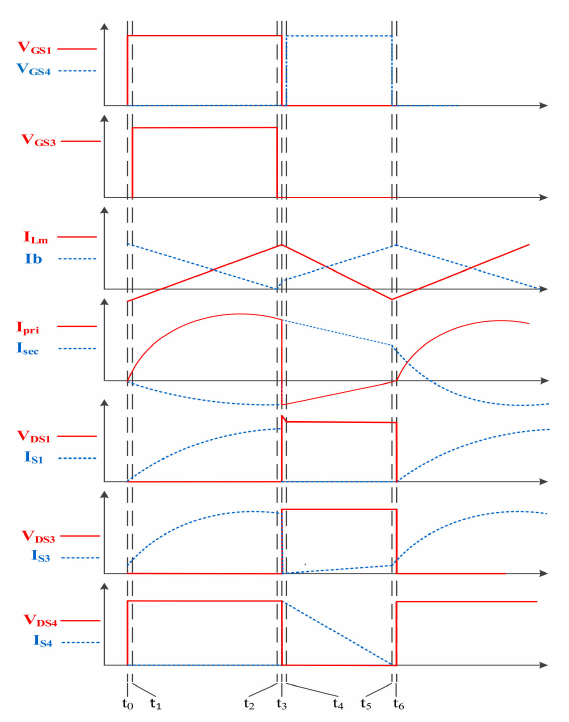
Figure 4. Key waveforms in Stage